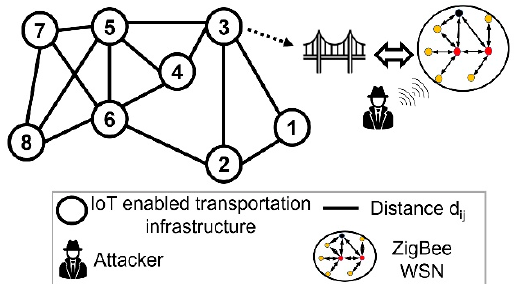
Figure 4. Case study of a cyber–physical transportation network